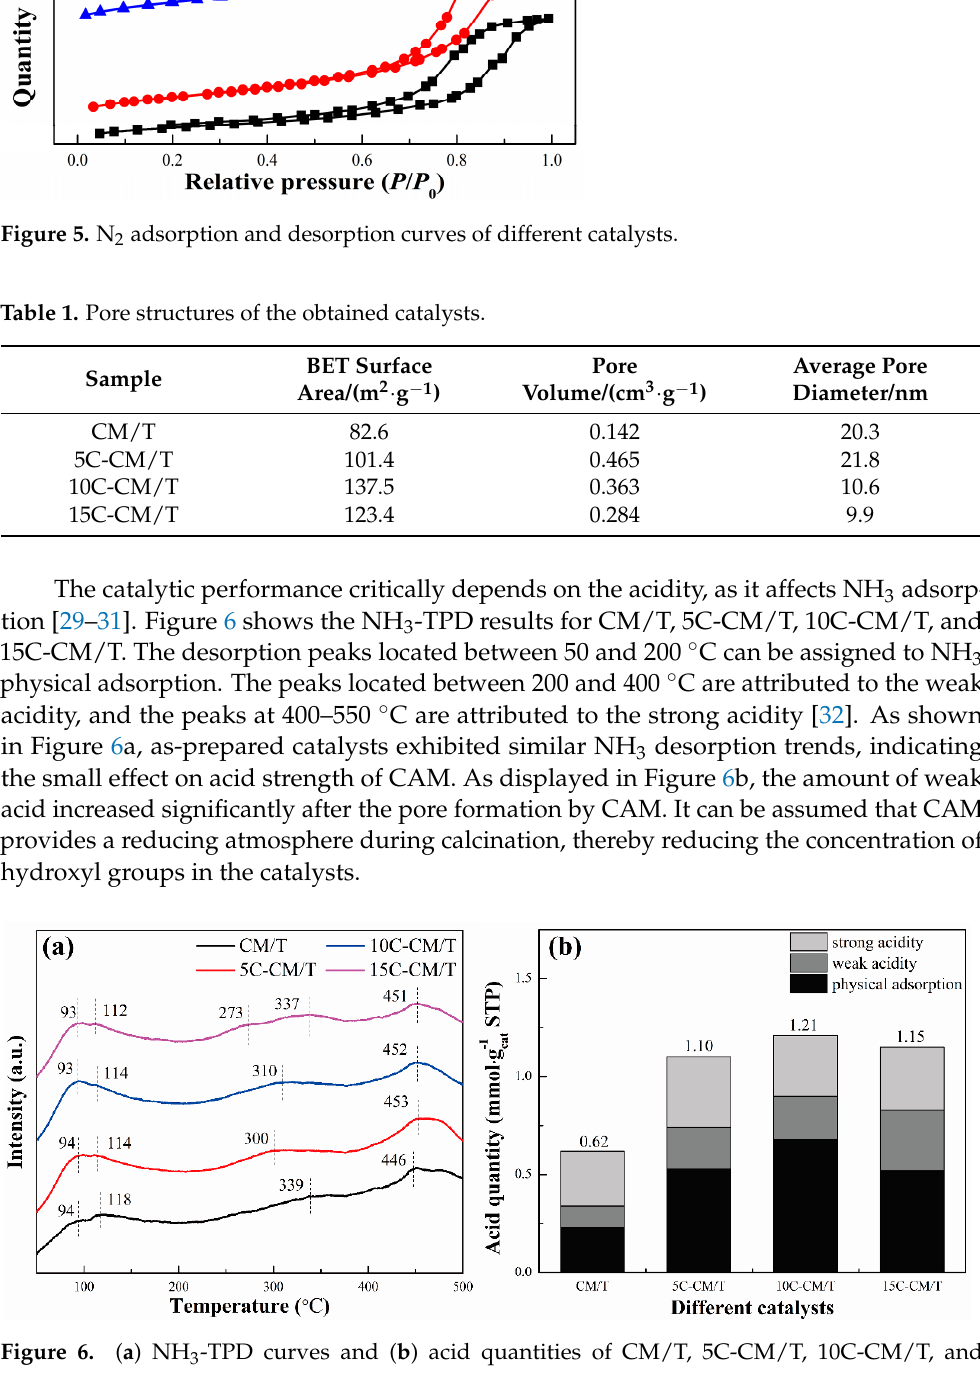
Figure 6. ( a ) NH 3 -TPD curves and ( b ) acid quantities of CM/T, 5C-CM/T, 10C-CM/T, and 15C-CM/T.